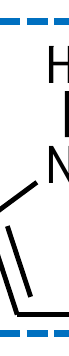
Figure 17. General structure of pyrrole-based dyes.